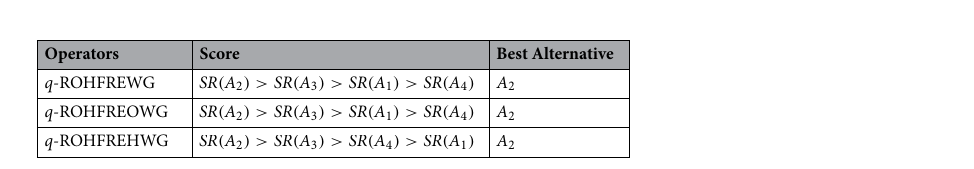
Table 15. The ranking of the alternatives.